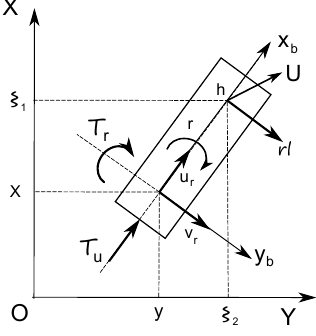
Figure 1. Underwater vehicle model